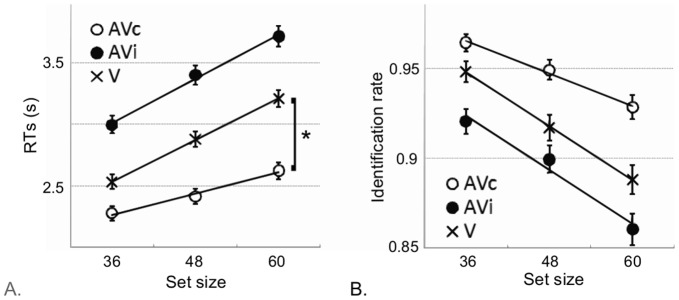
Effect of number of distracters on RT and identification rate collapsed over all temporal rates.Mean response times (A) and detection rates (B) per condition and per subject as a function of set size. Bars denote two SEM. A significant interaction was found between display condition and set size for RTs. The slope of the curve RTs  =  f(set size) was significantly lower in condition AVc than in condition AVi. The number of distracters affected the visual search less when a sound was synchronized with a target color change than in the absence of sound (V) or in desynchronized condition (AVi).